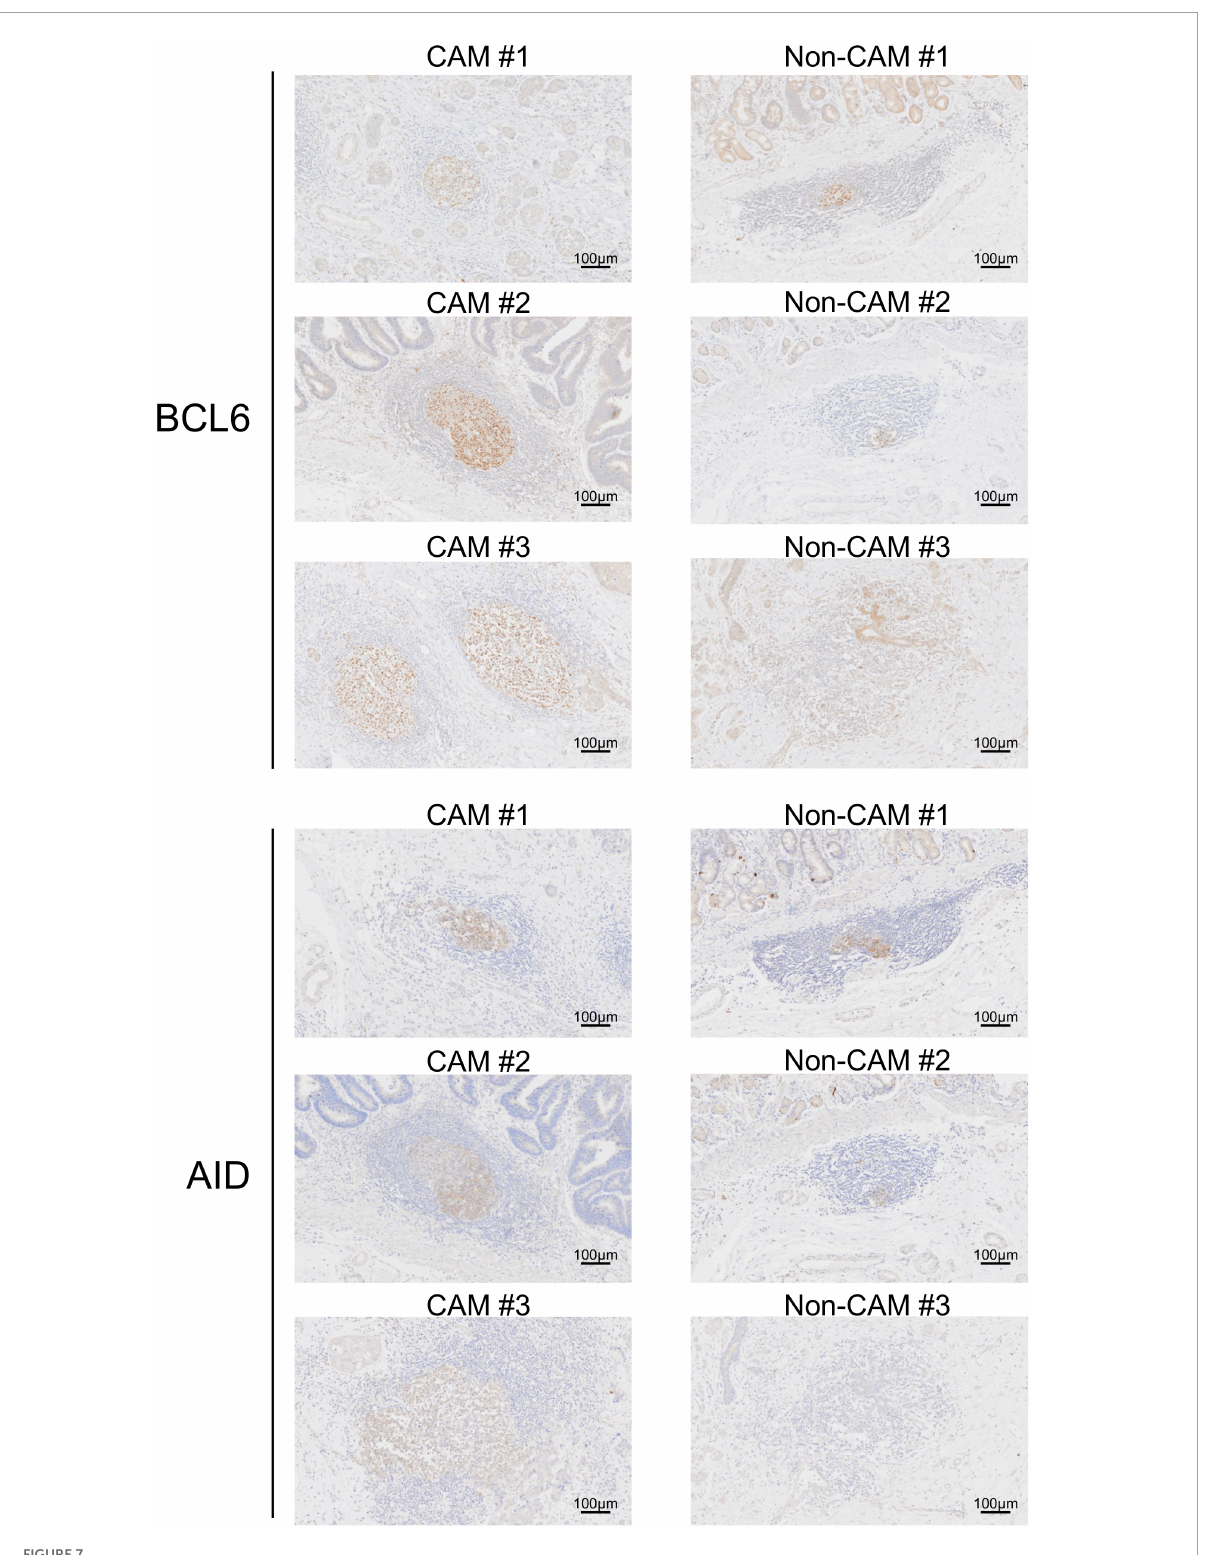
FIGURE7 BCL6 + cells and AID + cells in TLSs from CAM patients and non-CAM controls. Immunostaining for BCL6 or AID was conducted in representative TLSs from 3 CAM patients (CAM #1-#3) and 3 non-CAM controls (non-CAM #1-#3). Scale bar = 100 µ m. CAM, cancer- associated myositis; TLSs, tertiary lymphoid structures; BCL6, B-cell lymphoma 6; AID, activation induced